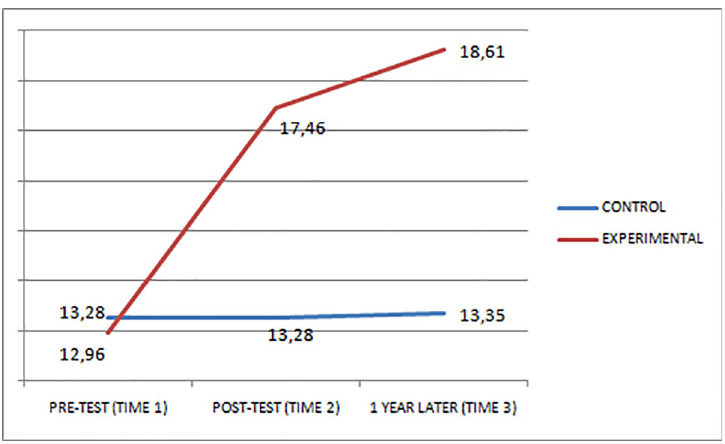
Fig 2. STEU performance of the groups at pre-test (Time 1), post-test (Time 2), and one year after (Time 3).